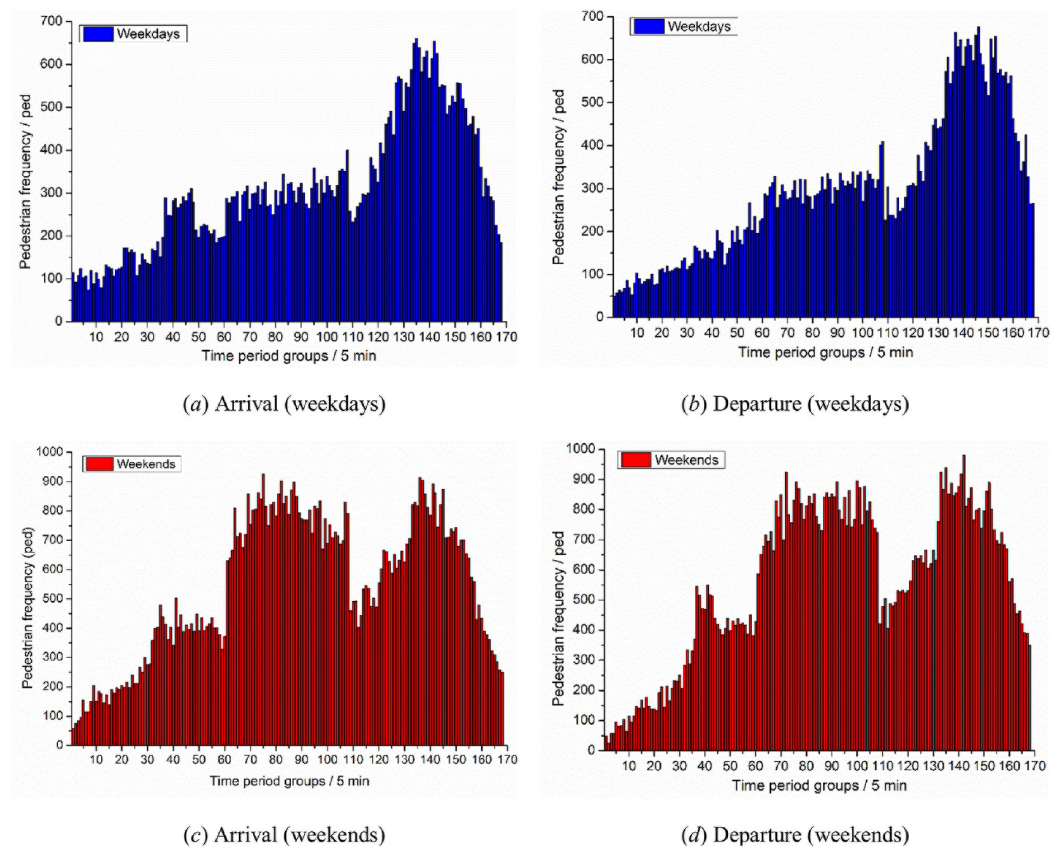
Fig 1. Results of pedestrian arrival-departure characteristics in the